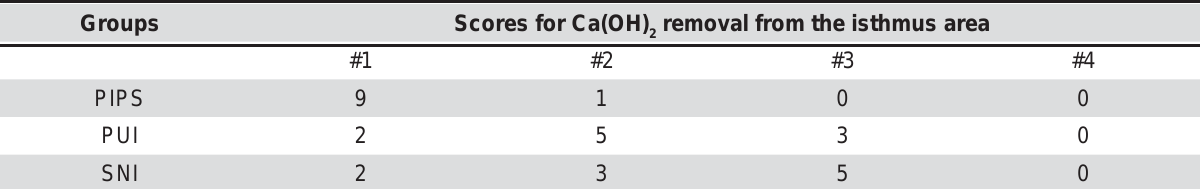
removal from the isthmus area for different irrigation 2